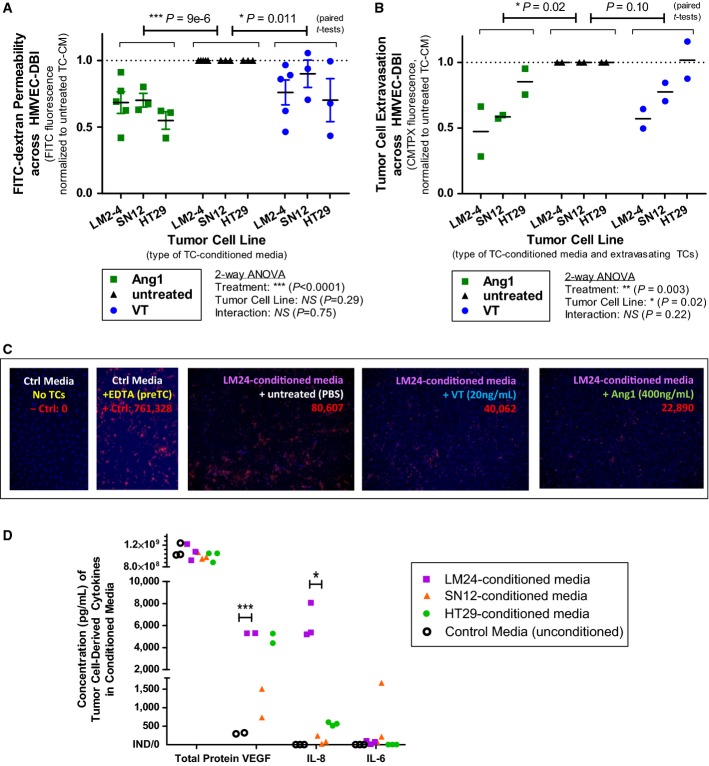
Endothelial cell-activating cytokines produced by Tie2− tumor cells may influence the anti-permeability efficacy of Vasculotide and Ang1

A, B In modified Boyden chamber experiments, confluent dermal HMVECs were stimulated with tumor cell-conditioned media (TC-CM)—that is, media conditioned by either LM2-4luc, SN12luc, or HT29luc tumor cells—and treated with 20 ng/mL Vasculotide vs. 400 ng/mL Ang1 (positive control) vs. PBS (negative control). Meta-analyses of treatment effects on dextran permeability (A) and tumor cell migration (B), where each datapoint represents the mean of an independent experiment, averaged over 2–3 biological replicates (inserts) per treatment group and normalized internally within that same experiment. Statistical significance of overall Ang1 or VT treatment effects was determined by paired t-tests, n = 11 (A) or 6 (B) experimental replicates.

C Representative fluorescent images (10×) of ‘extravasated’ CMTPX-labeled TCs (red) fixed on membrane undersides.

D LM2-4luc produced the highest levels of VEGF and IL-8, but lower levels of IL-6, compared to other TC types; ***P < 0.001 and *P < 0.05 (unpaired t-tests).